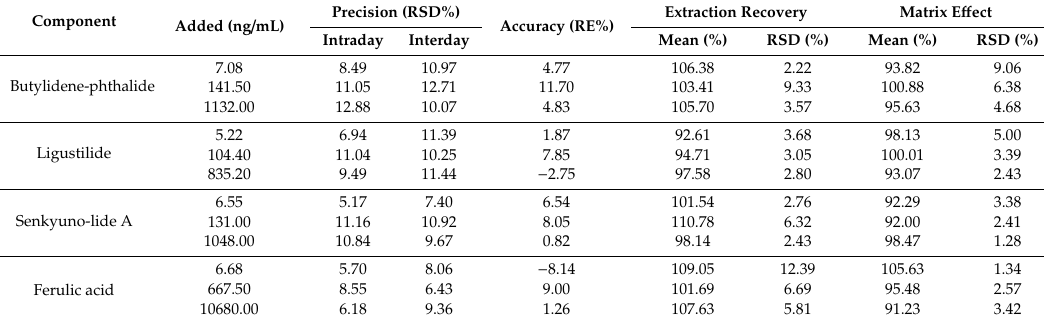
Table 2. Precision, accuracy, extraction recovery and matrix e ff ect of butylidenephthalide, ligustilide, senkyunolide A and ferulic acid in rat plasma. ( n = 3 days and six replicates per